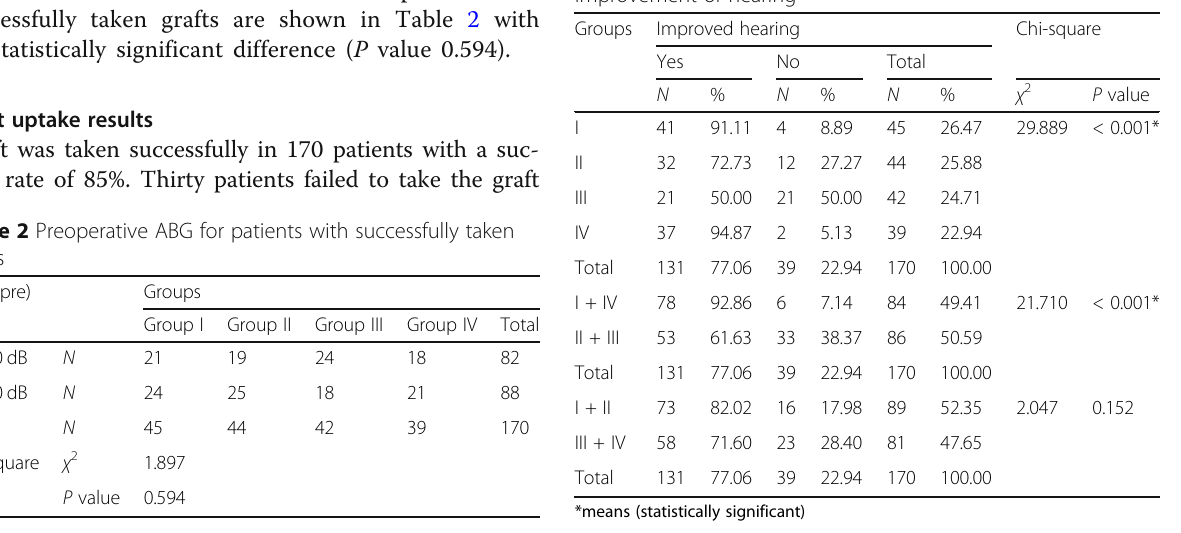
Table 4 The comparison between different groups as